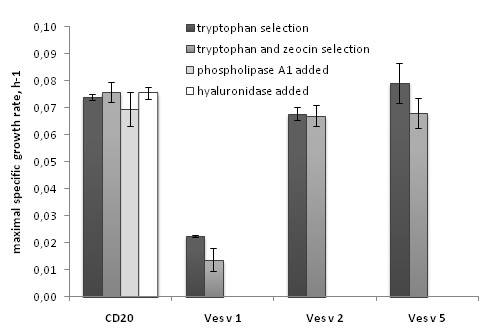
Maximal specific growth rates of yeast cells expressing reference protein (CD20) and wasp venom allergens. Maximal specific growth rates of cells grown on galactose under tryptophan selection (first columns) or combined tryptophan and zeocin selection (second columns) were measured in triplicates. The error bars show standard deviation. Two extra columns demonstrate the effect of extracellular addition of phospholipase A1 or hyaluronidase on the growth rate of CD20-expressing cells.